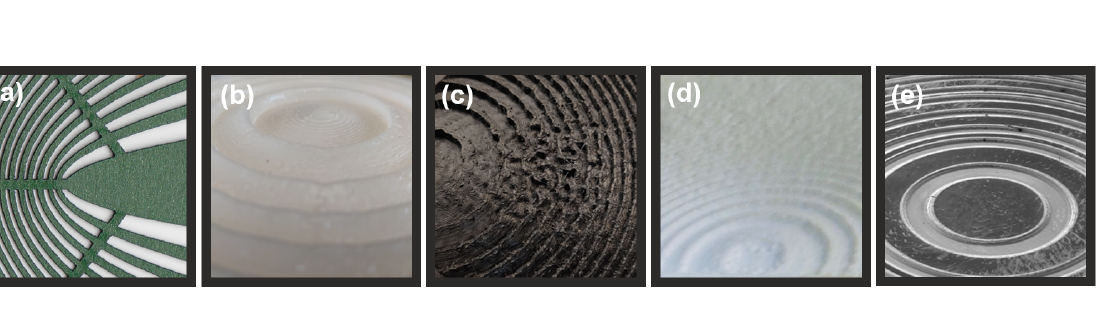
Figure 6. Different THz diffractive optical structures manufactured using: ( a ) laser cutting to manufacture hyperbolic lens [9] from paper, ( b ) extrusion-based 3D printing to make a mold to form converging lens from paraffin, ( c ) extrusion-based 3D printing from PA12 for off-axis focusing lens, ( d ) selective laser sintering (powder-based 3D printing) from PA12 to manufacture point-to-point redirecting lens and ( e ) ablation in silicone to fabricate Fibonacci lens (photograph courtesy Linas Minkeviˇcius, FTMC,